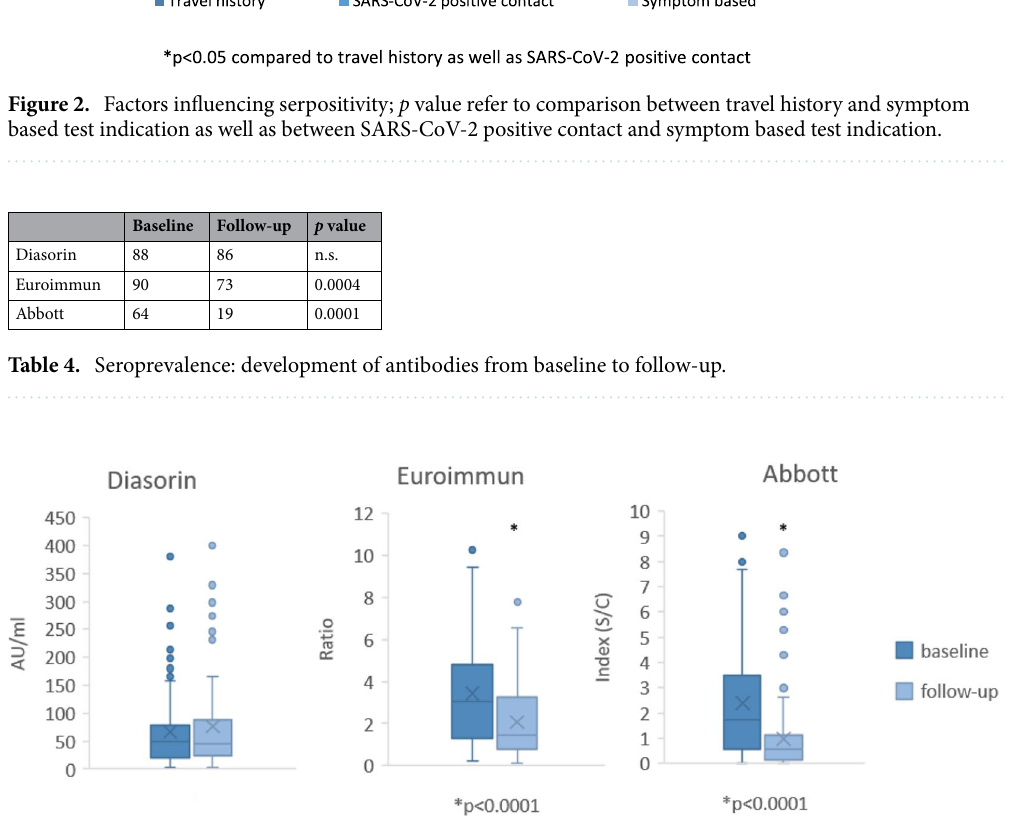
Figure 3. Mean antibody levels over time in different assays; p value refer to comparison between baseline and